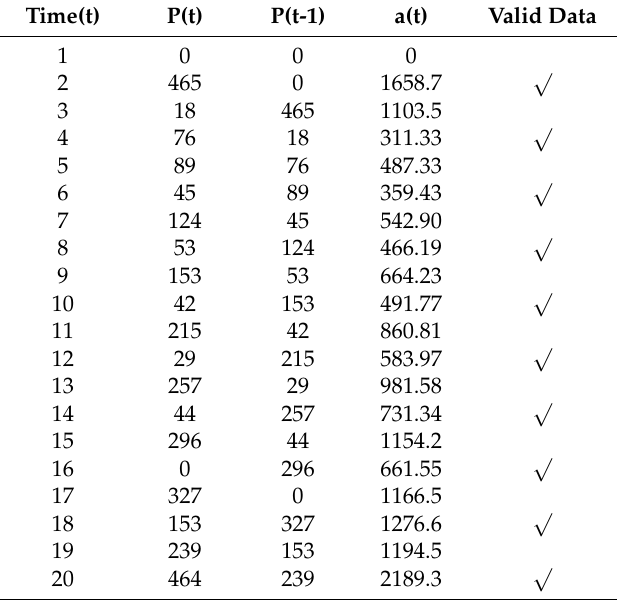
Table 1. Dynamic neuron time representation.